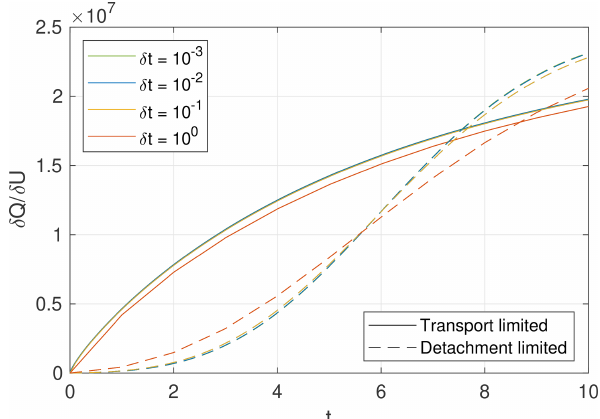
Figure 6. Change in sediment flux per change in uplift rate for dif- ferent time increments δt obtained from the steady-state topography with uniform uplift considered in Sect.